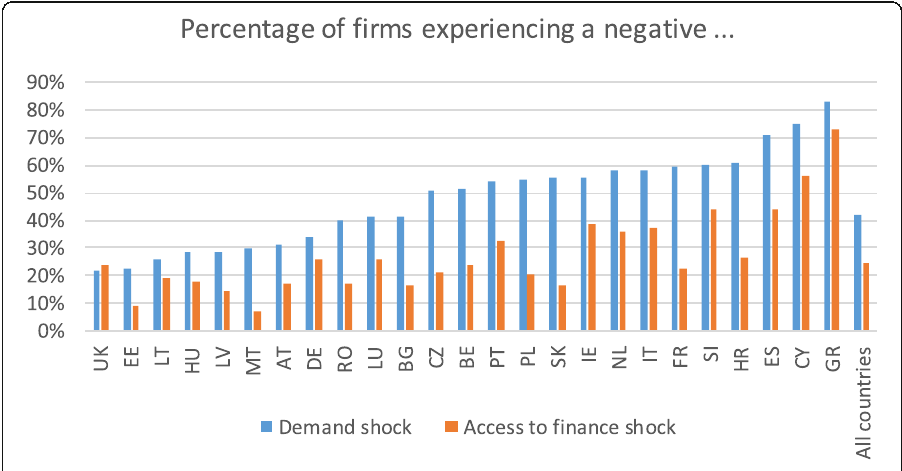
Fig. 4 Demand and access to finance shocks in WDN3. Note: Weighted by the number of firms in the firm